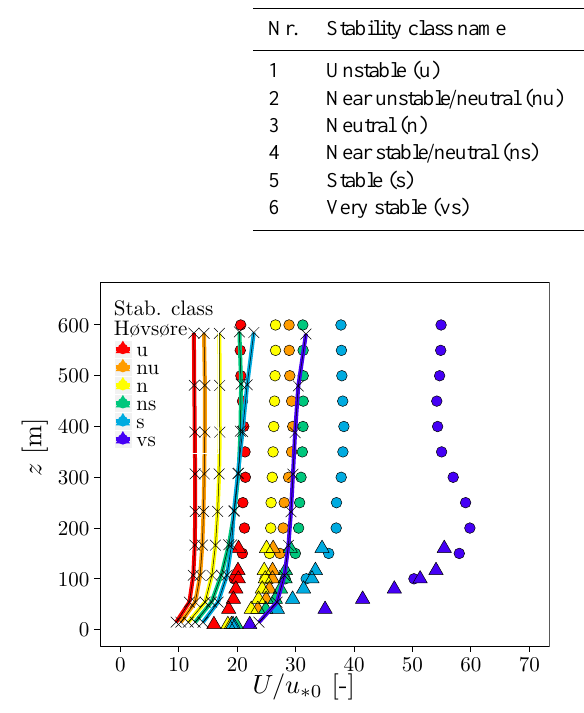
Figure 6. Profiles of normalized wind speeds as function of sta- bility (Table 1). The full lines represent WRF simulations and the symbols measurements as in Fig. 5. The friction velocity that is used to normalize the wind speed for the measurements is taken from the meteorological mast, and for WRF from the simulation.